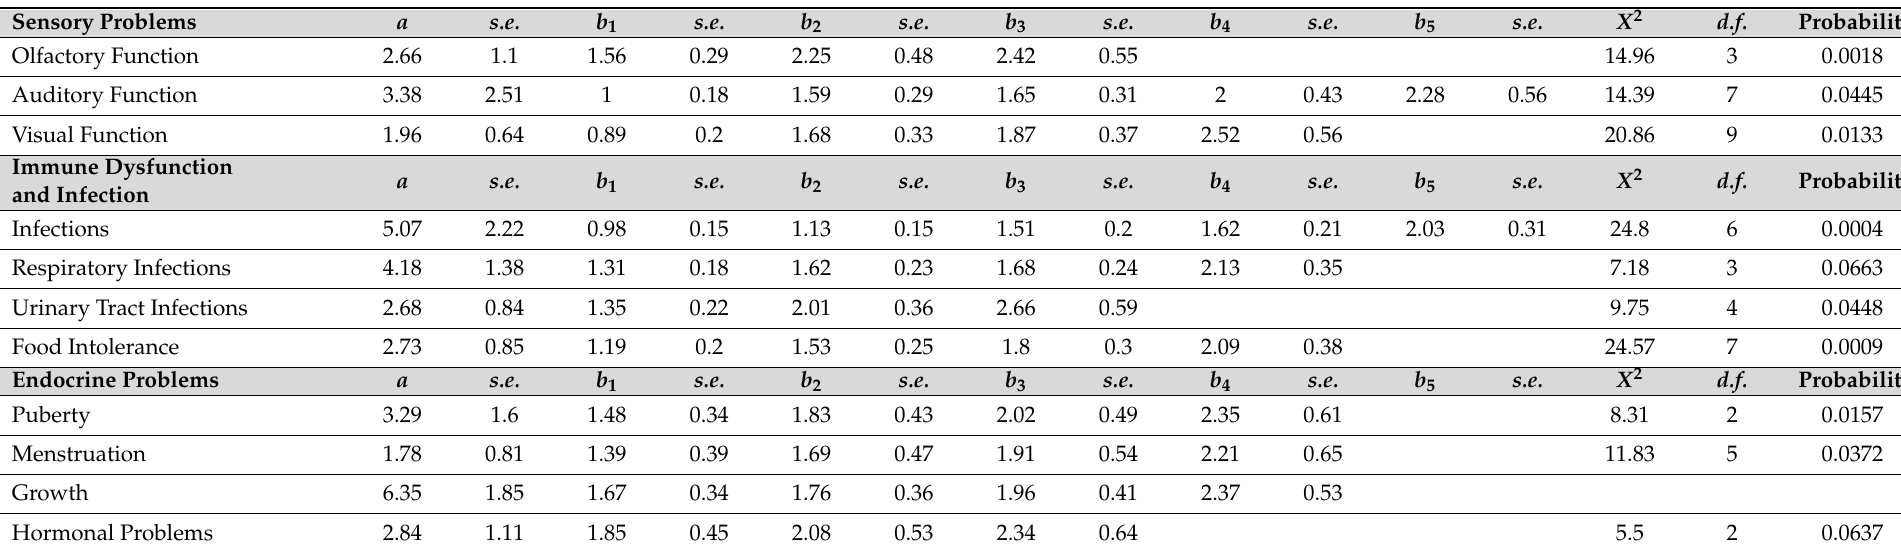
Table 2. Multi-System Profile of Symptoms Scale Supplement—Item Response Theory